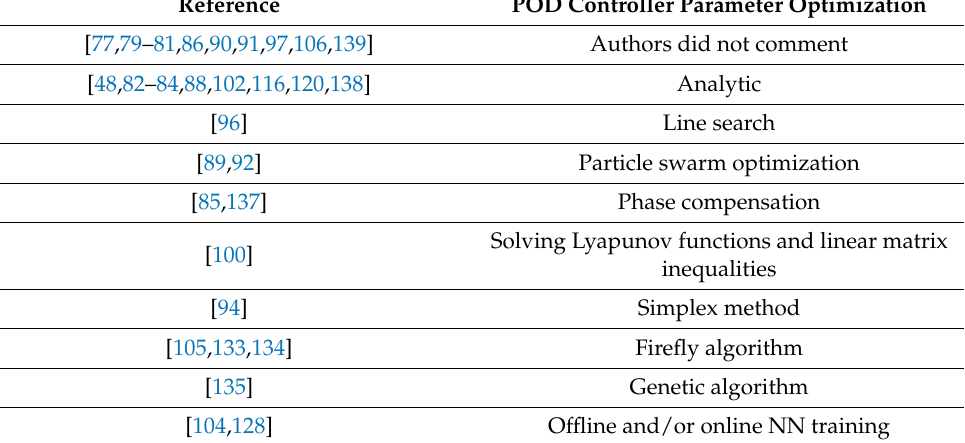
Table 5. POD optimization